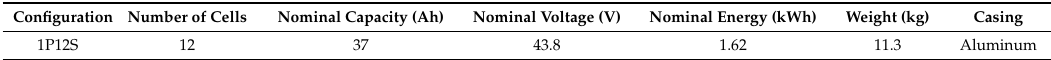
( b ) Figure 2. The composition of the battery module: ( a ) Actual appearance with dimensions; and ( b ) a simplified model. 3.3. Experimental Method There are two general modal test methods, one uses the roving impact hammer and the other uses the shaker to rove the accelerometer [36]. According to the reciprocity assumptions of modal analysis, the modal parameters measured by these two methods should be consistent. The difference was that the roving impact hammer test was to get one of the rows of the FRF matrix, whereas the shaker test was to obtain one of the columns of the FRF matrix. However, the exciter required equipment such as a signal source and a power amplifier, which were difficult to install. In addition, the energy generated during the experiments by the exciter was higher, and compared to the use of the impact hammer, the data had a better consistency and more uniform energy distribution, which was suitable for more complex mechanical structures. The battery cell and module structures were relatively simple, so the method of the roving hammer was used for EMA. In the aspect of the signal